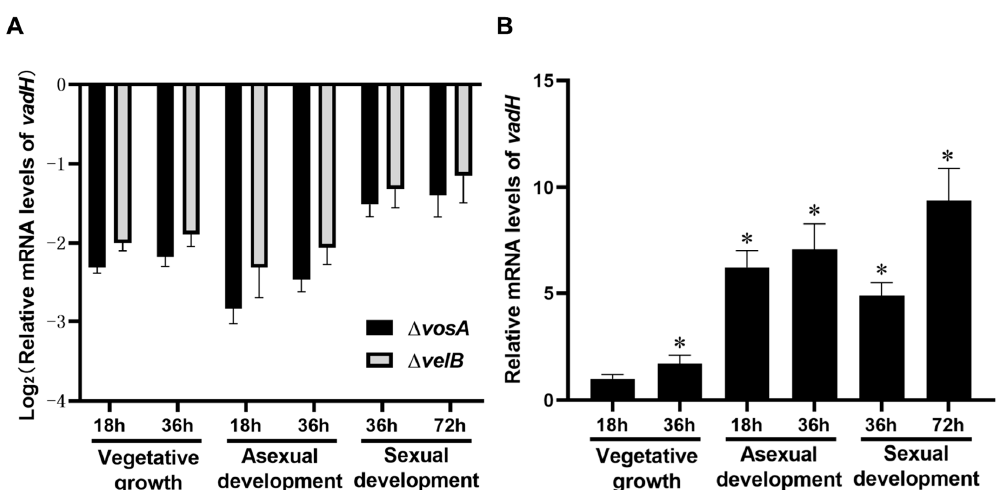
Figure 2. Relative mRNA levels of vadH . ( A ) Relative expression levels of vadH in ∆ vosA and ∆ velB . ( B ) Relative expression levels of vadH in WT during three stages. The expression level of vadH at 18 h of the vegetative growth stage was set to 1. The asterisks represent significant level (* p < 0.05).